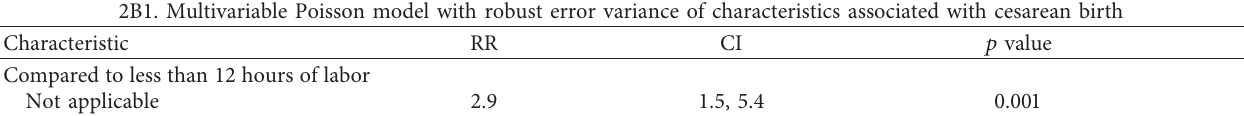
Table 2B. Multivariable model of characteristics associated with cesarean birth and association of cesarean birth with pregnancy